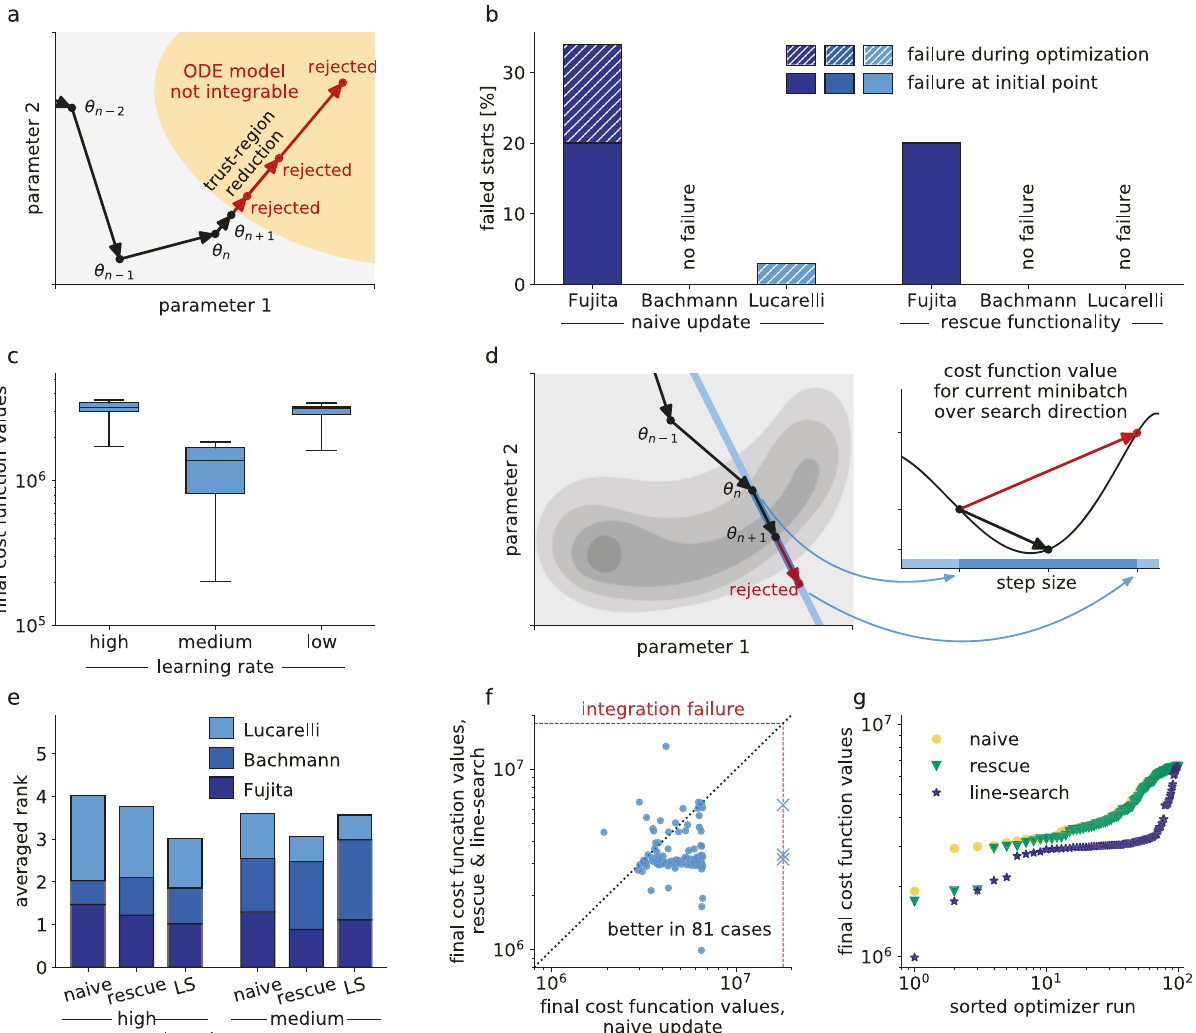
Fig. 3 In fl uence of line-search methods on optimizer ’ s performance and reliability. a Schematic of the rescue interceptor, which tries to recover from failed model evaluations, based on one-dimensional trust regions. b Percentage of failed local optimizations per model (with optimizer Adam) due to non- integrability of the underlying ODE. Failure at the initial point of optimization cannot be recovered, but failure during the optimization process is prevented when applying the rescue interceptor. c Boxplots for the best 25 starts of mini-batch optimizers Adam for learning rate Schedules 1 – 3 for the largest example (Lucarelli), showing that too high learning rates obstruct the optimization process. Medians are indicated as thick lines, boxes extend from 25th to 75th percentiles, whiskers show the ranges of the data. d Line-search for mini-batch optimizers is implemented based on backtracking while keeping the mini-batch fi xed during line-search. e Comparison of performance for optimizer Adam, given different learning rates, for naive implementation, with rescue interceptor, and rescue interceptor and line-search, denoted as LS (ranks of models averaged). f All starts of the local optimizer Adam for the largest of the three examples (Lucarelli), naive implementation compared against rescue interceptor and line-search, employing learning rate Schedule 1. g Waterfall